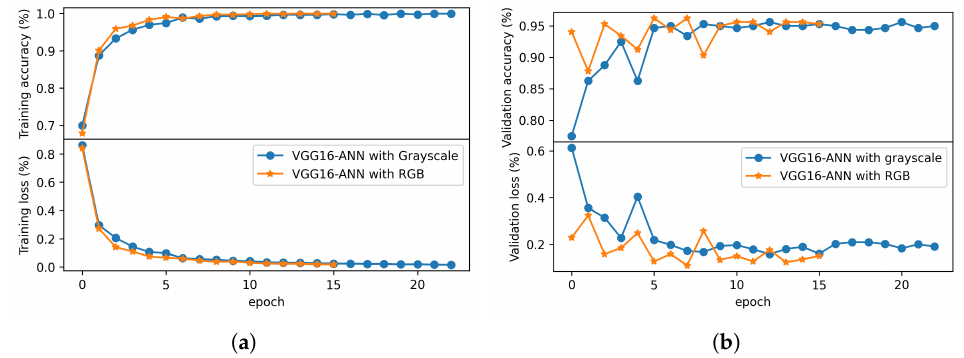
Figure 7. Side-by-side comparison of the ( a ) training and ( b ) validation of VGG16-ANN models being trained on the RGB and greyscale